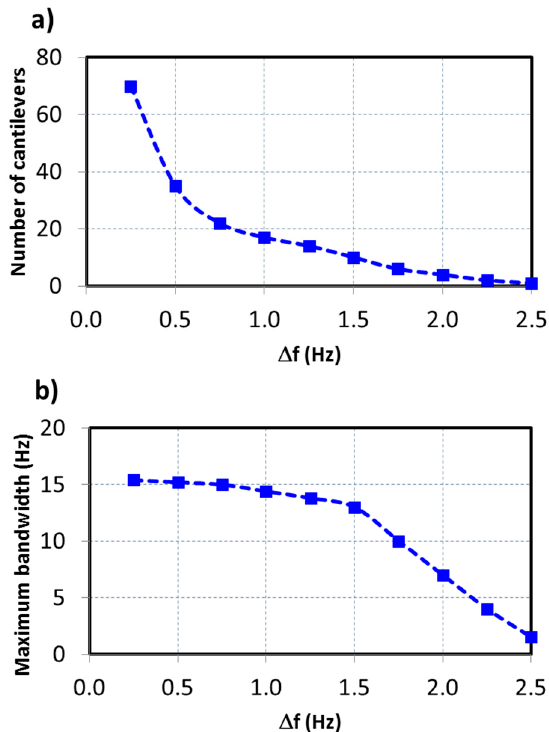
Figure 9. ( a ) Simulated dependence of the number of cantilevers on the frequency detuning ∆ f ;